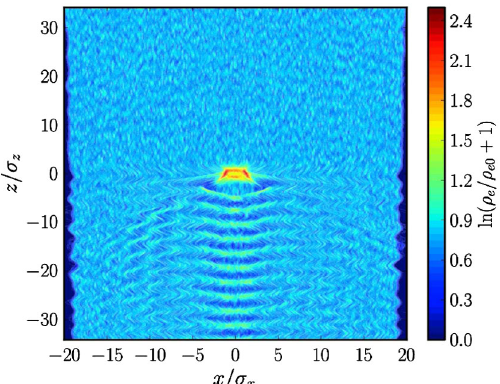
FIG. 6. Electron cloud density contour obtained from the 2D ES simulation for an electron cloud density n e ¼ 10 16 m (cid:2) 3 . The initial electron cloud charge density (cid:2) e 10 16 m (cid:2) 3 , is used to normalize the color